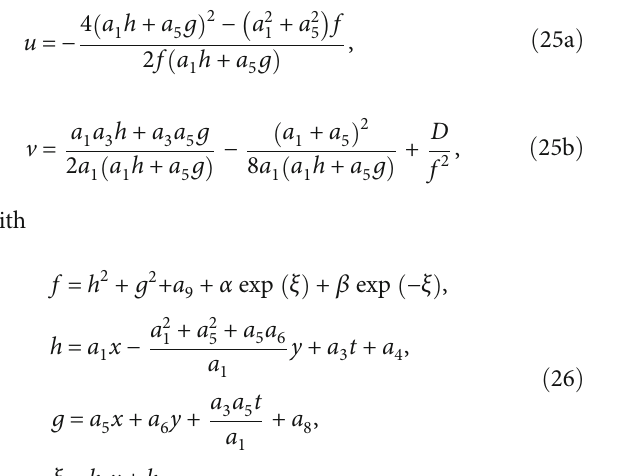
= 1 , a = 0 , a = 2 , a = 4 , a = 0 , a = 1 , α = 1 , β = 1 , k 1 4 5 6 8 9